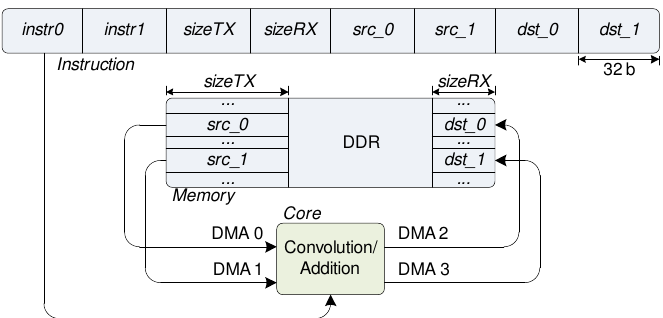
Figure 7. The format of instructions for the convolutional core.